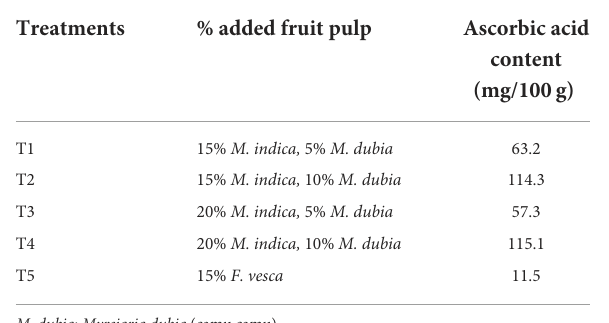
concentration of freeze-dried M. dubia seed extract in yogurt. The by-products of this fruit produced yogurt enriched with these bioactive